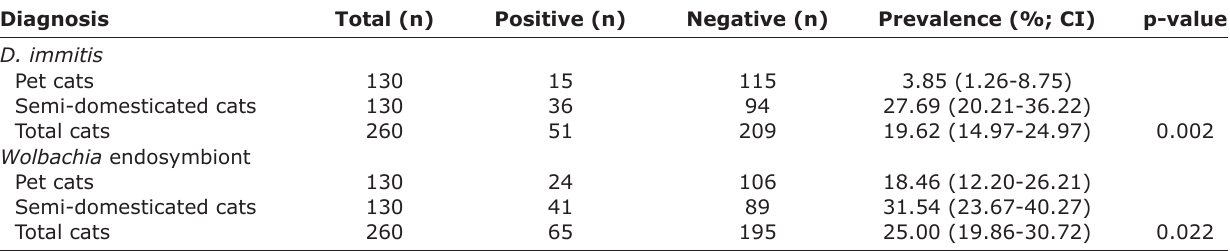
Table-2: Summary of D. immitis and Wolbachia endosymbiont infections in pet and semi-domesticated cats. Diagnosis